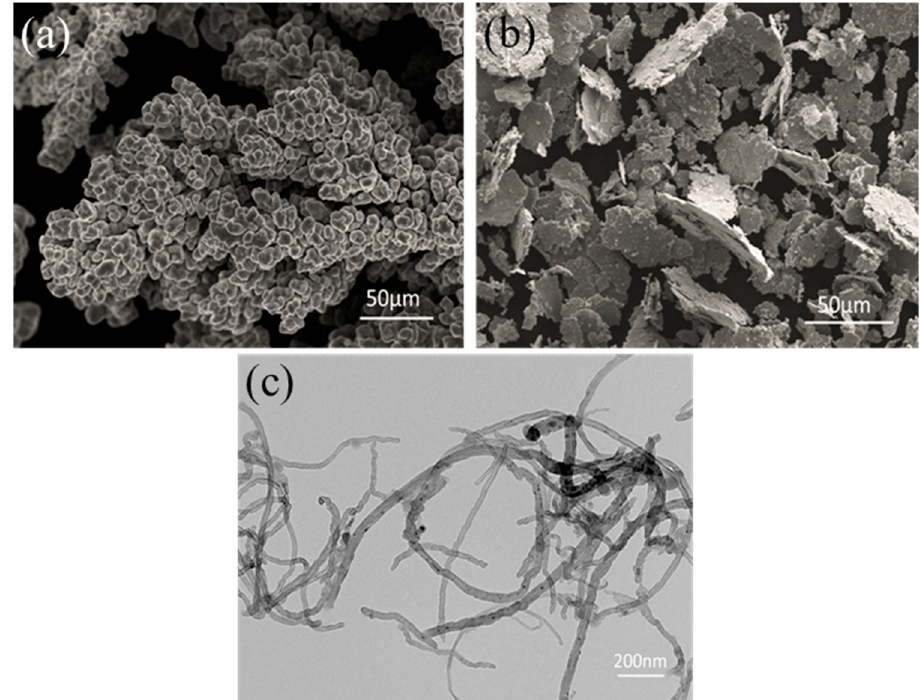
Figure 2. ( a ) SEM images of the electrolytic copper powder; ( b ) SEM image of the flaky Cu powder; ( c ) TEM image of the CNTs.